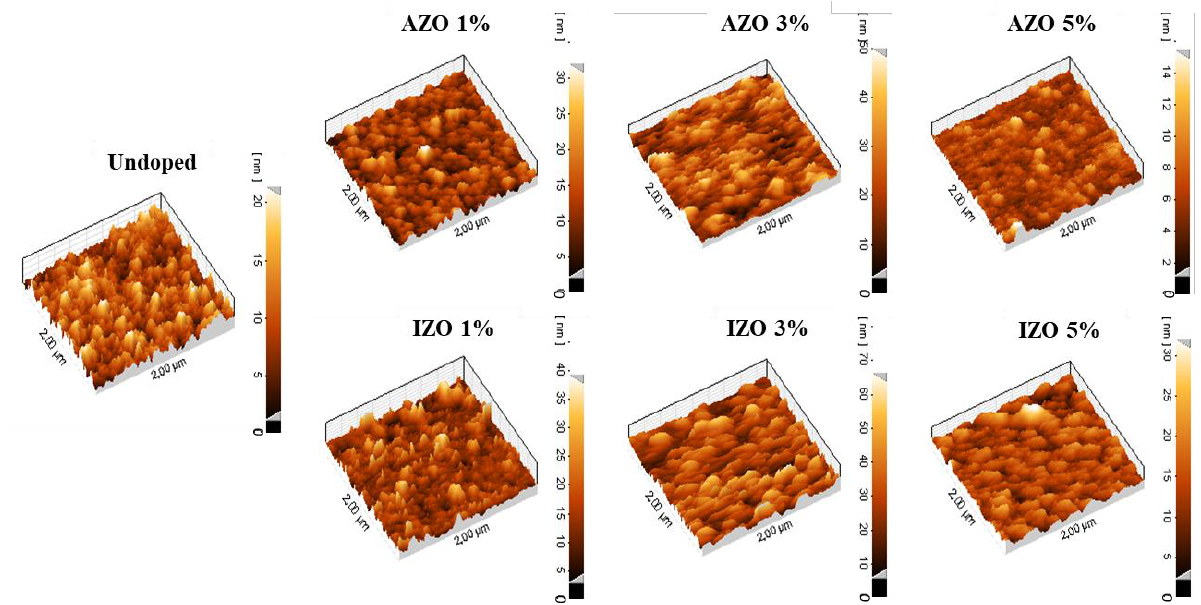
Figure 4. Three-dimensional AFM images of undoped ZnO, AZO, and IZO thin films deposited at various doping concentrations.